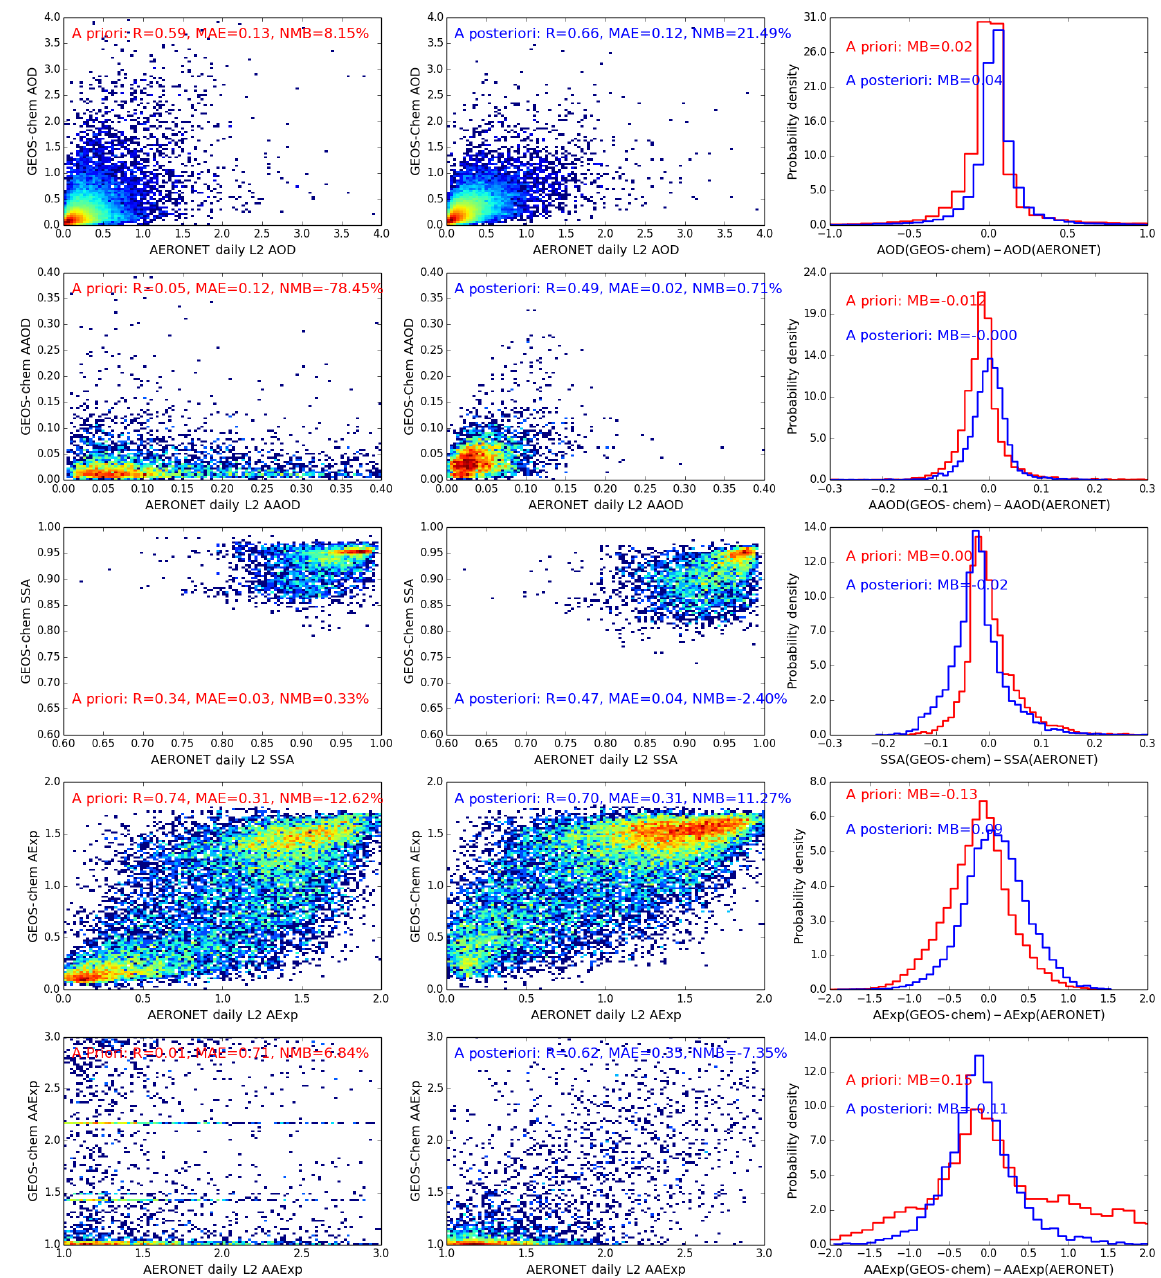
Figure 6. Comparison of a priori and a posteriori GEOS-Chem simulated AOD, AAOD, SSA at 550nm, AExp (440–870nm), and AAExp (440–870nm) with AERONET Level 2 daily aerosol products. The data for density plots are all aggregated into 100 bins for both x and y directions spanning from minimum to maximum values on the axes. The correlation coefficient ( R ), mean absolute error (MAE), normalized mean bias (NMB), and mean bias (MB) are also provided in the